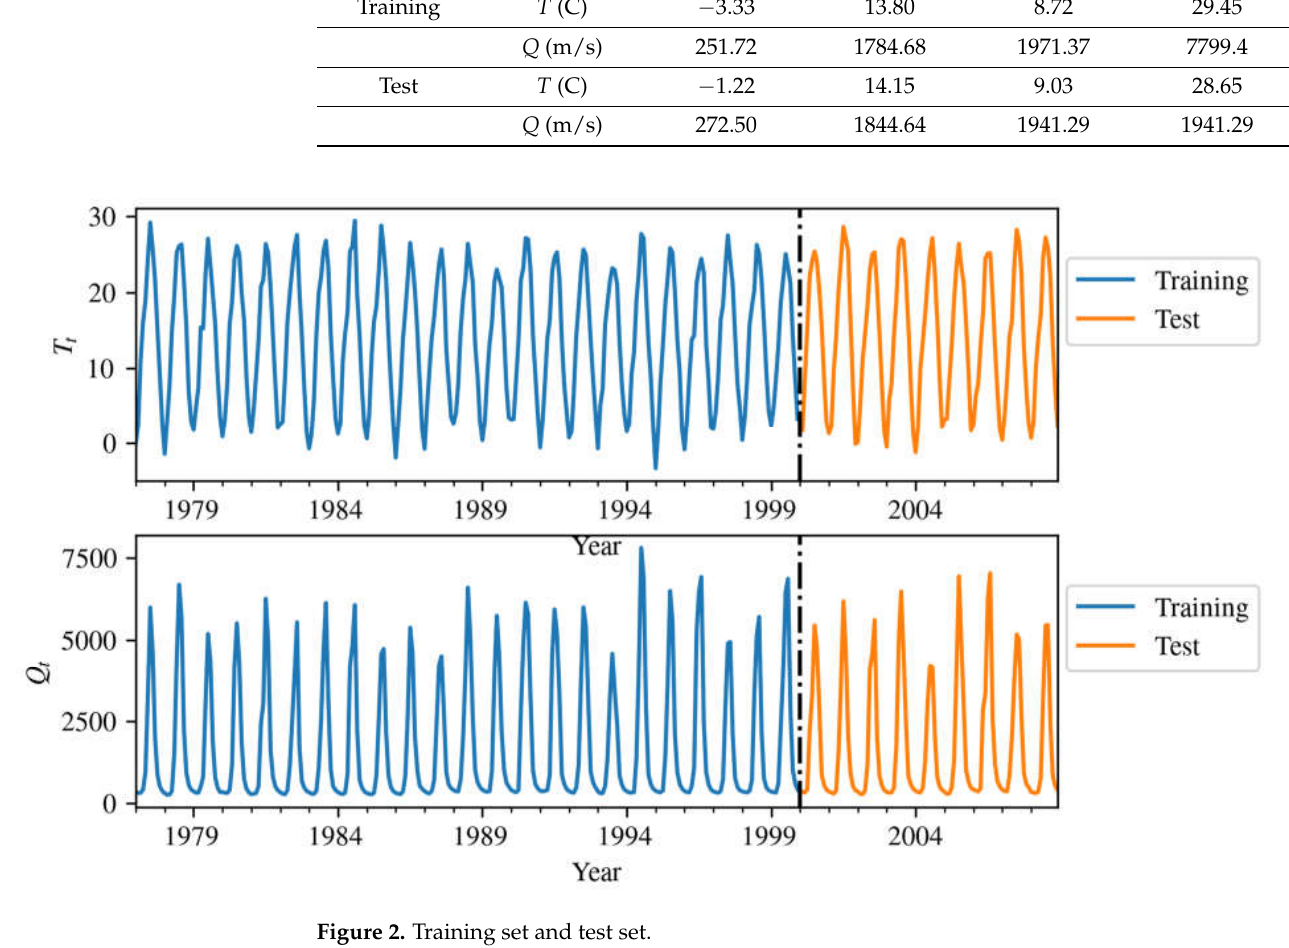
Figure 2. Training set and test set.